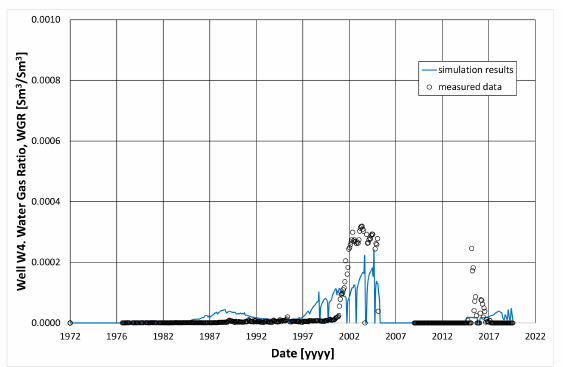
Figure 17. Model calibration. Comparison of measured bottom-hole pressure and simulation results. Well W4.